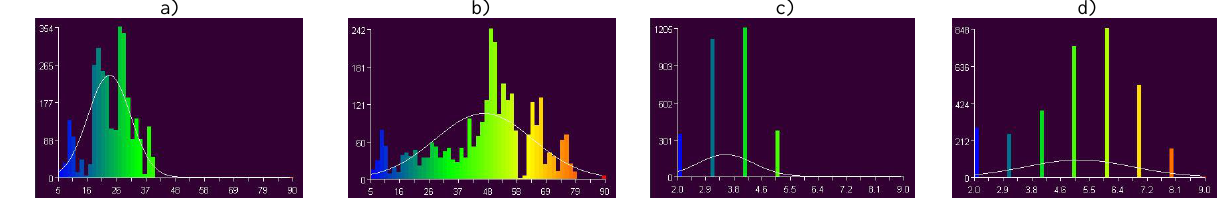
Figure 3: Distribution of the computed 3D points colored according to their intersecting angles: a) network with only normal images (mean= 24°, max=39°), b) network with normal and convergent images (mean=45°; max=89°). Distribution of the computed 3D points colored according to their multiplicity in the images: c) network with only normal images (mean=3; max=5), d) network with normal and convergent images (mean=5;